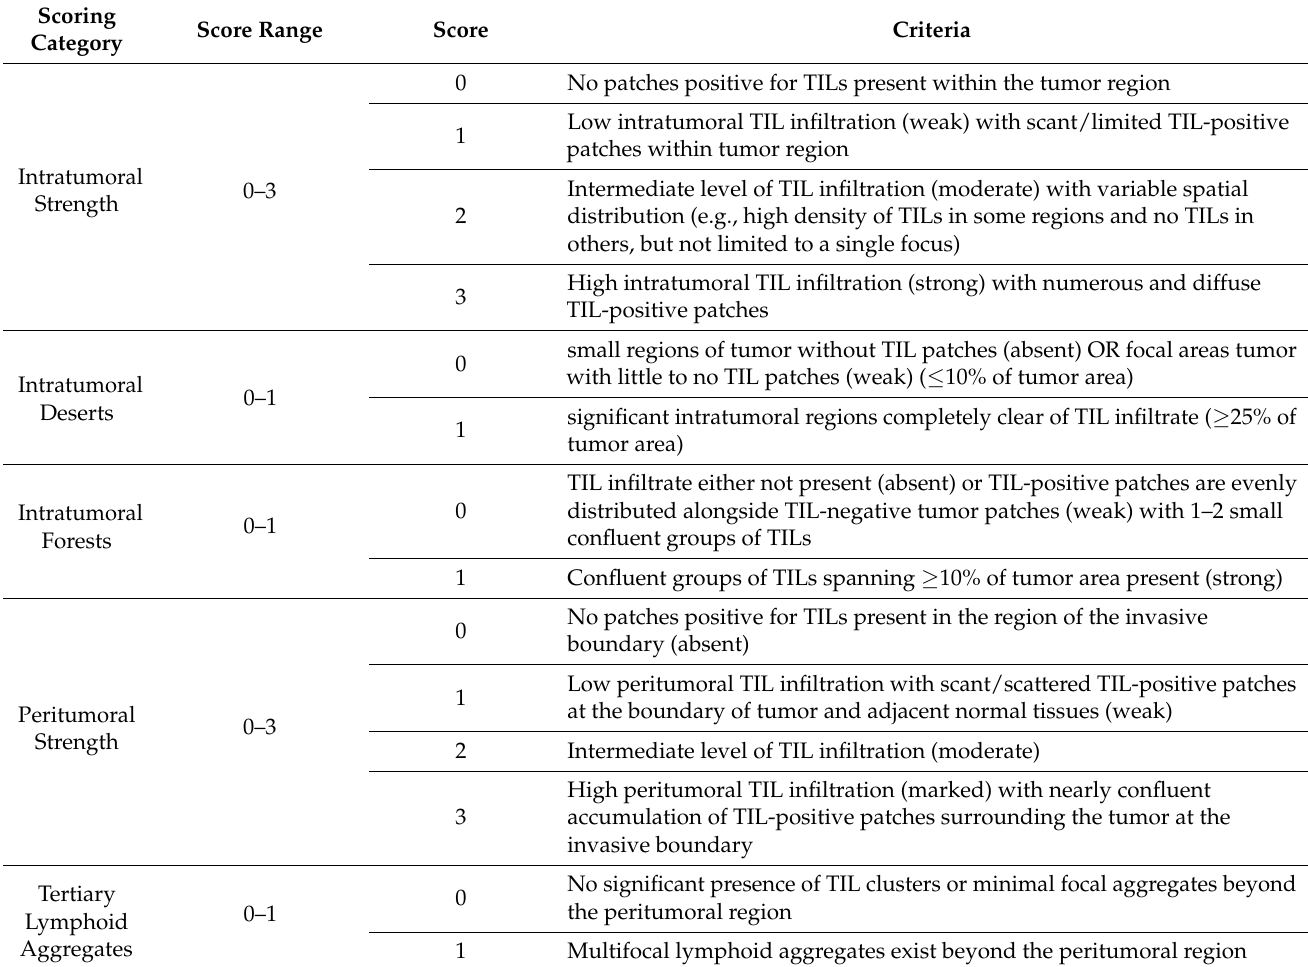
Table 2. Descriptions of spatial features of Tumor-TIL maps and scoring criteria. Representative images for each score and category are shown in Figure